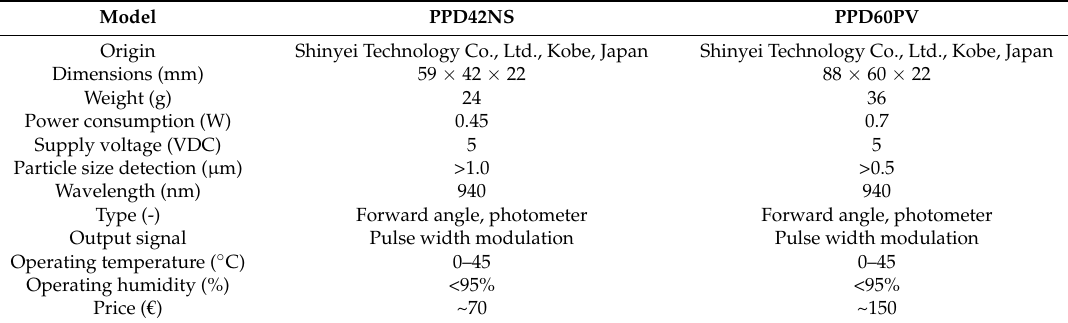
Table 1. List of properties of the Shinyei sensors declared by the